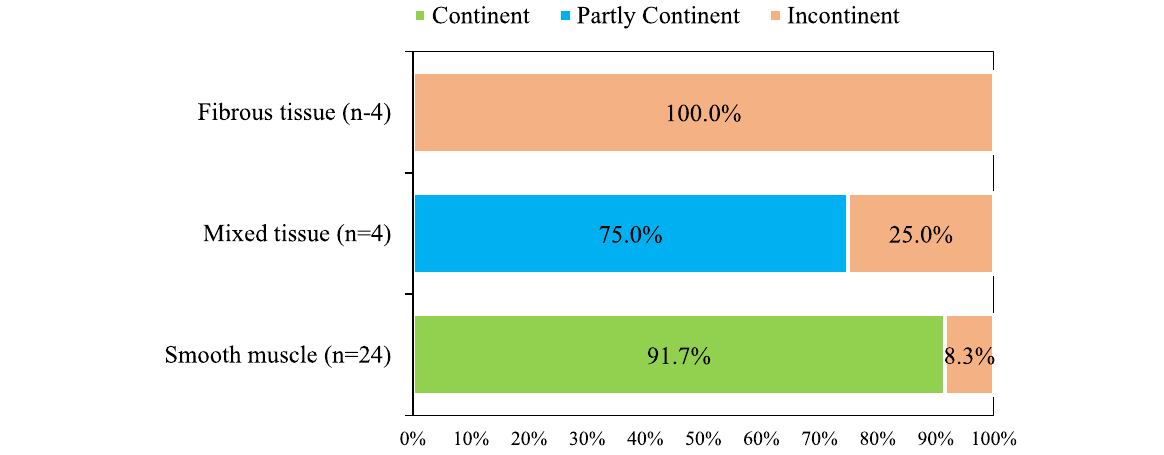
Fig. 7 Bar chart depicting continence status in patients with different histopathological